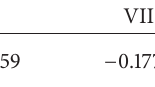
Table 1: Statistics for the variation trends of PW in different regions.